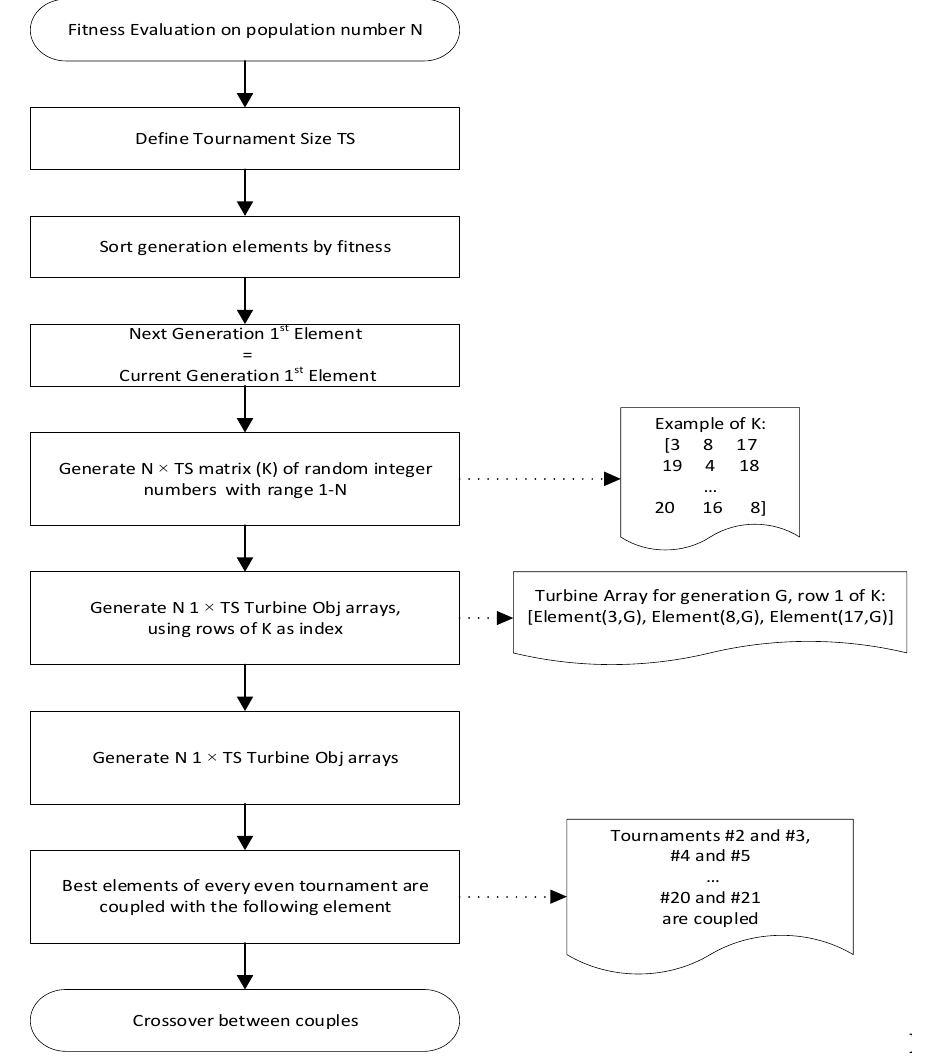
Figure 5. Schematic of parent selection methodology, utilizing tournament selection, and